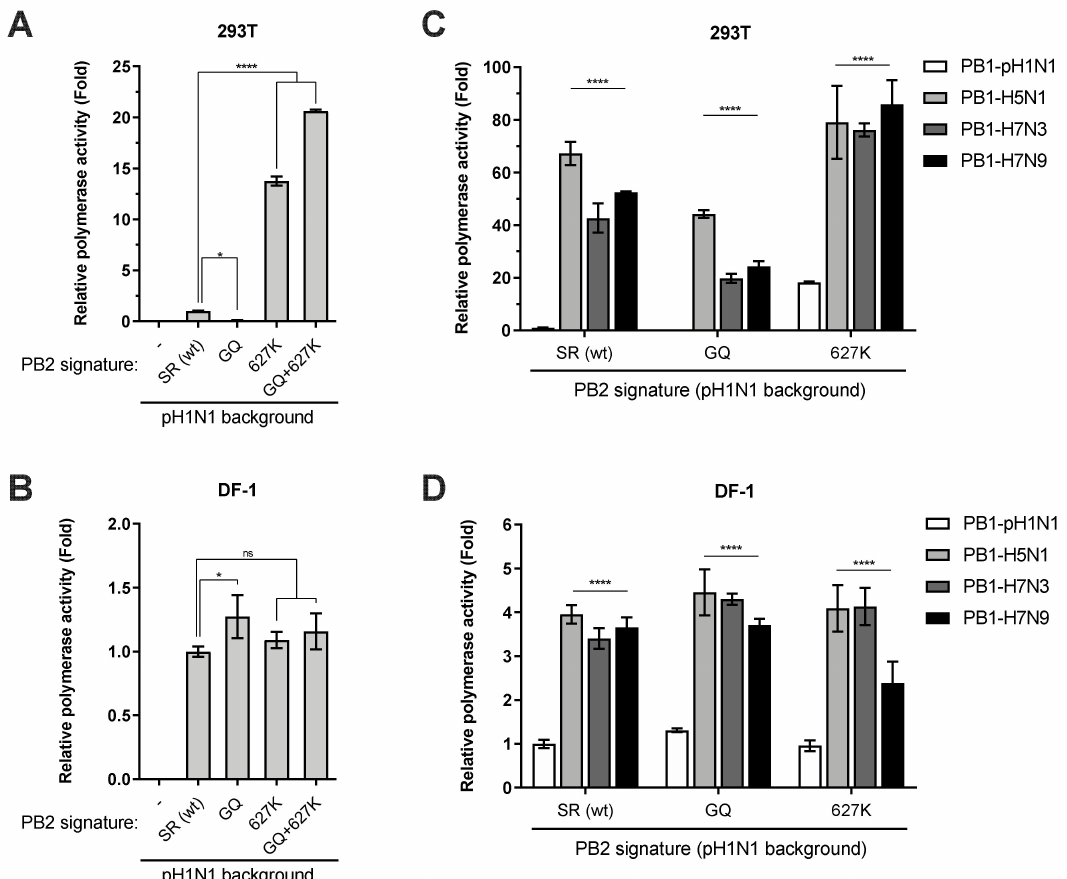
Figure 2. Avian-origin PB1 enhances 2009 pH1N1 polymerase activity independently of PB2 adaptive mutations. ( A and B ) 293T ( A ) or DF-1 ( B ) cells were co-transfected with plasmids expressing PB1, PA, and NP proteins of pH1N1 virus along with indicated PB2 carrying S590G / R591Q (GQ), E627K (627K), or GQ + 627K mutations.( C and D ) The PB1 gene of pH1N1 polymerase harboring indicated PB2 signatures was replaced by that of avian H5N1, H7N9, or H7N3 in 293T ( C ) or DF-1 ( D ) cells. The relative luciferase activity was determined at 24 h.p.t. and expressed as fold